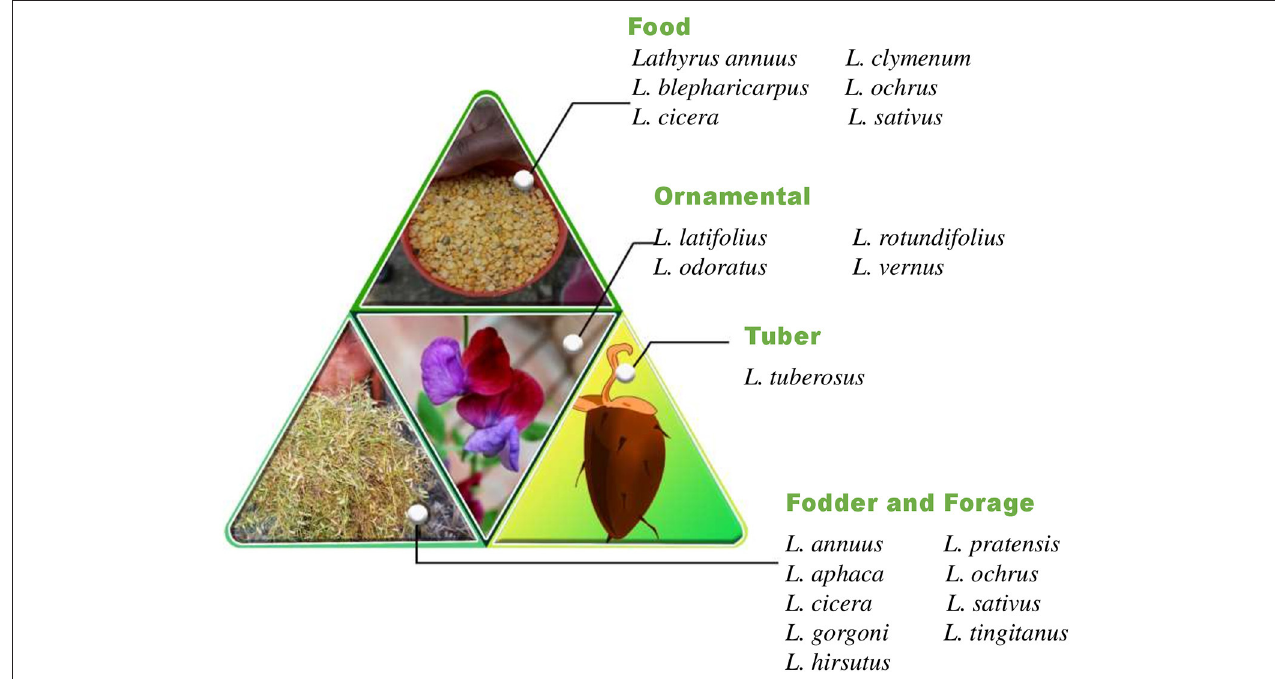
FIGURE 1 | Lathyrus species and its uses (14,